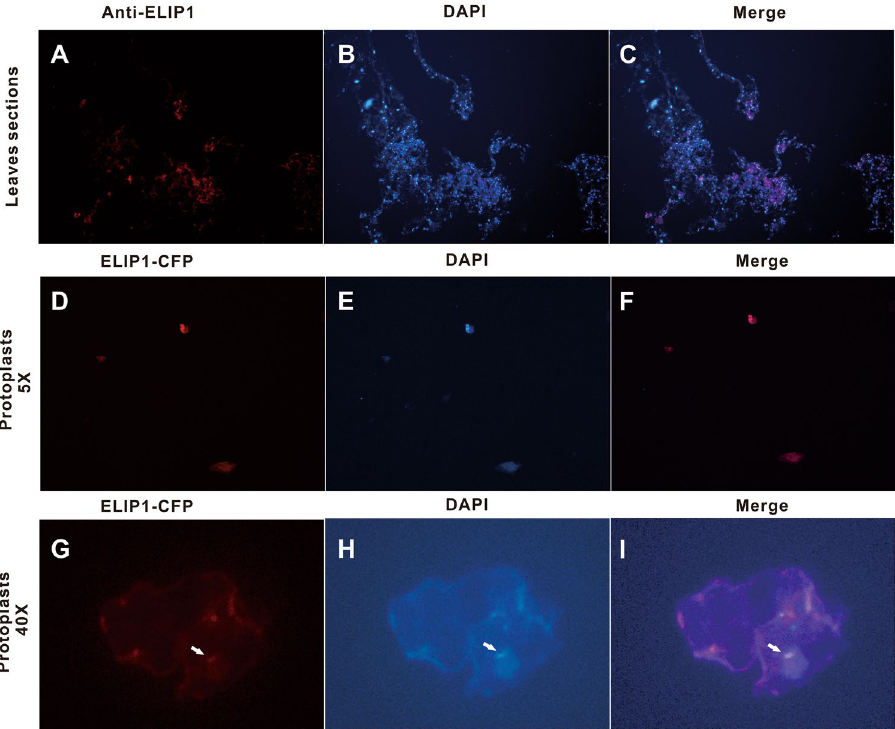
Figure 3. Tissue and subcellular localization of ELIP1. ( A ) Tissue localization of ELIP1 on the upper epidermis of Chinese cabbage leaf. ( B ) DAPI staining. ( C ) Merged. ( D ) Transfection of ELIP1-CFP fusion protein into Chinese cabbage protoplasts. The microscope eyepieces was in quintuple vision. ( E ) DAPI staining in Chinese cabbage protoplasts. The microscope eyepieces was in quintuple vision. ( F ) Merged. The microscope eyepieces was in quintuple vision. ( G ) ELIP1-CFP fusion protein in nucleus of Chinese cabbage protoplasts. ELIP1-CFP was marked by the white arrow. The microscope eyepieces was in 40 times vision. ( H ) DAPI staining in